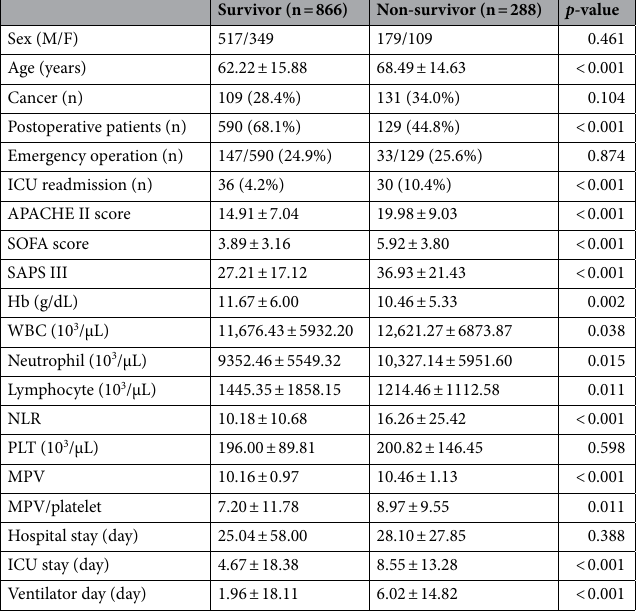
Table 1. Baseline characteristics and outcome variables stratified according to 1-year mortality. Values are presented as the mean ± standard deviation or number of patients (%). ICU, intensive care unit; APACHE II, Acute Physiology and Chronic Health Evaluation; SOFA, Sequential Organ Failure Assessment; SAPS III, Simplified Acute Physiology Score; Hb, haemoglobin; WBC, white blood cell; NLR, neutrophil to lymphocyte ratio; PLT, platelet; MPV, mean platelet volume; HOD, hospital